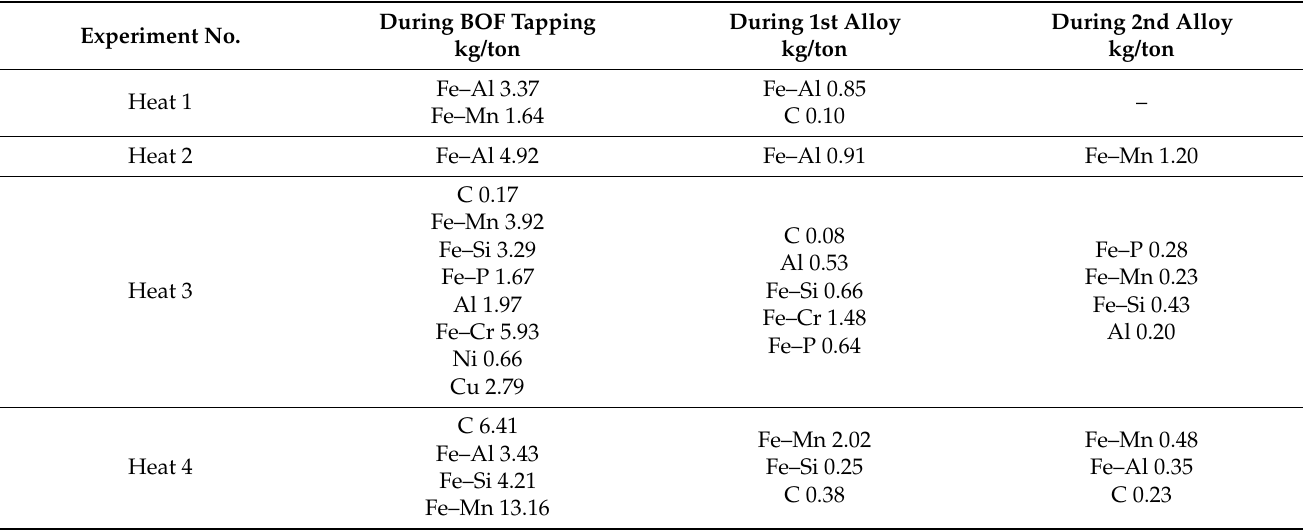
Table 2. Amount and timing of the added alloys in each heat.